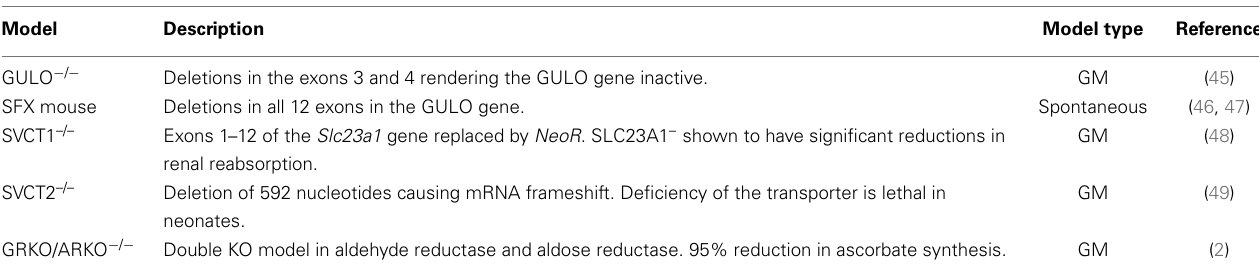
Table 2 | Current ascorbate deficient murine models